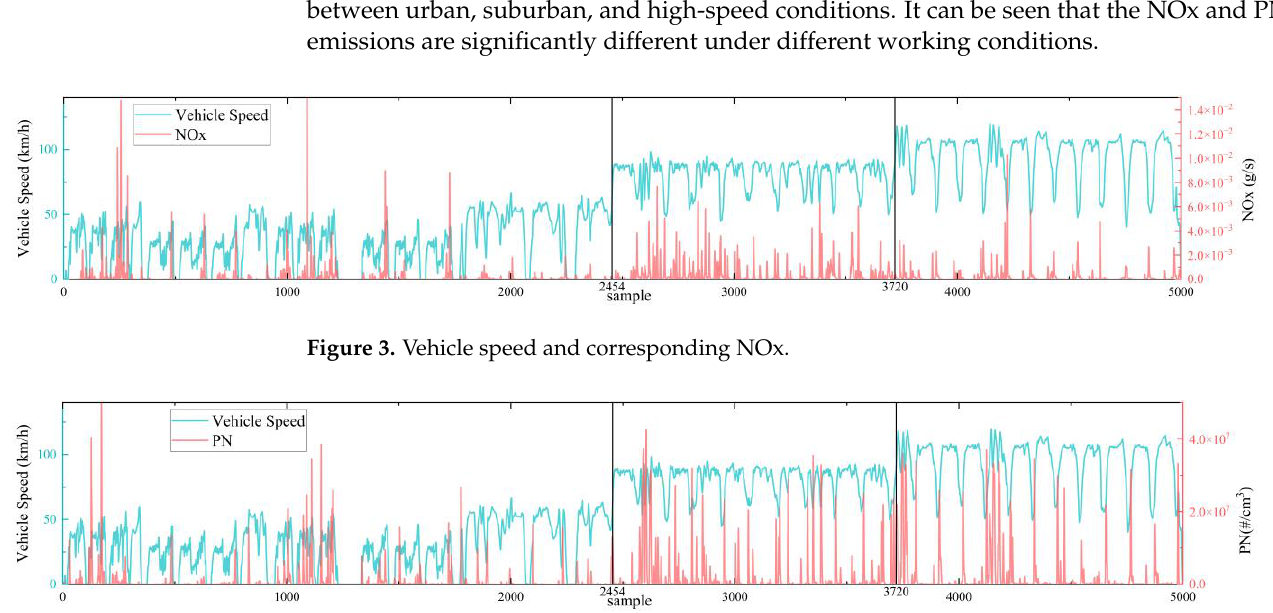
Figure 4. Vehicle speed and corresponding PN.